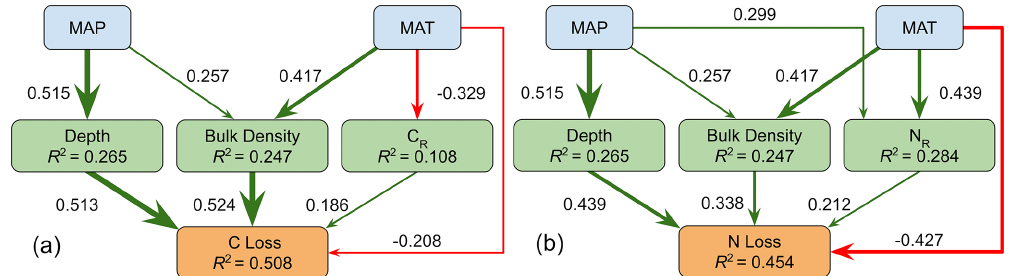
Figure 5. Diagram of proposed pathways for the effects of mean annual precipitation and mean annual temperature on C (a) and N (b) loss. Non-climate variables regard the organic layer. Each variable node is labeled with the R 2 from simple or multiple regression using explanatory variables represented by all incoming arrows. Arrows are labeled by and sized in proportion to the magnitude of their standardized regression coefficients and are significant. Green arrows represent positive relationships while red represent negative relationships. Omitted for simplicity are direct correlations between bulk density to C R ( p = 0 . 010, r = 0 . 356) and depth to N R ( p = 0 . 010, r = − 0 . 363).